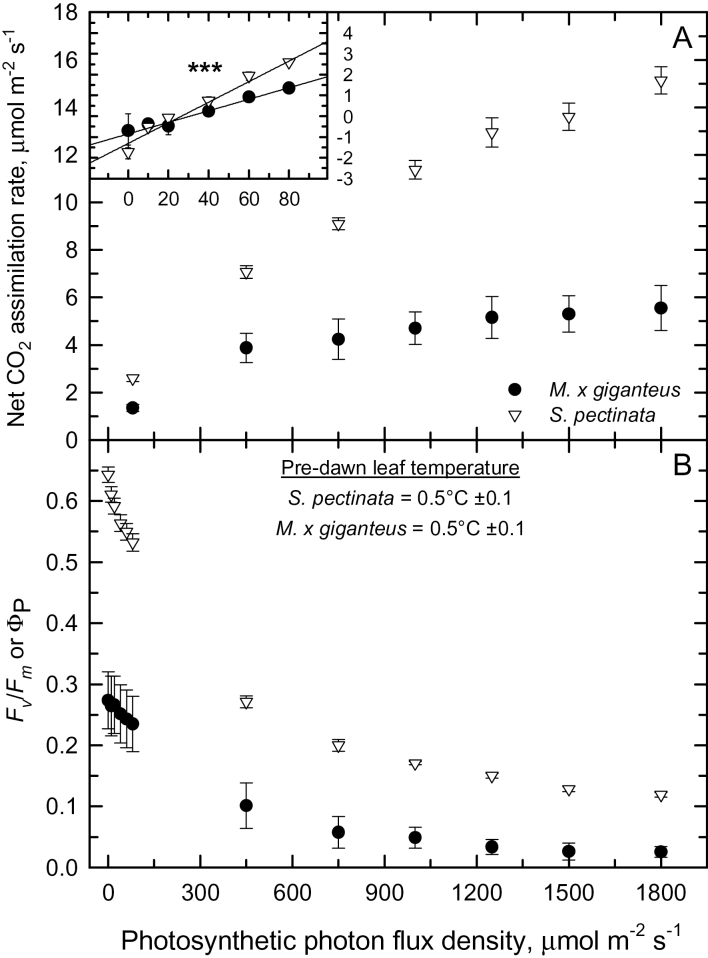
Photosynthesis after a mild frost in Miscanthus × giganteus and three Spartina pectinata accessions ‘Red River’, ‘IL-102’, and ‘Summerford’ (pooled means). (A) The light response of the net CO2 assimilation rate and (B) F
v
/F
m and ΦP. Measurements were conducted on 17 May 2014 after a mild frost event earlier that day. Means ±SE, n=5–12 for net CO2 assimilation rate, 3–5 for F
v
/F
m, and 2–5 for ΦP. Measurements were made at ambient CO2 concentrations of 400 µmol mol-1 and leaf temperatures of 10.7°C (±0.4) for M. × giganteus and 10.9°C (±0.3) for S. pectinata. T-tests show both parameters are significantly different between the species at each light intensity (p<0.01). (Inset) The light response of net CO2 assimilation rate and light intensity between 0 and 80 µmol photons m-2 s-1 for Miscanthus × giganteus and pooled measurements of the three Spartina pectinata genotypes. Means ±SE, n=3–5 at 0 PPFD and 5–8 for all other light intensities. The maximum incident quantum yield of CO2 assimilation (ΦCO2max) was calculated as the slope of the linear regression shown for each species. Asterisks indicate significantly different slopes (p<0.001).